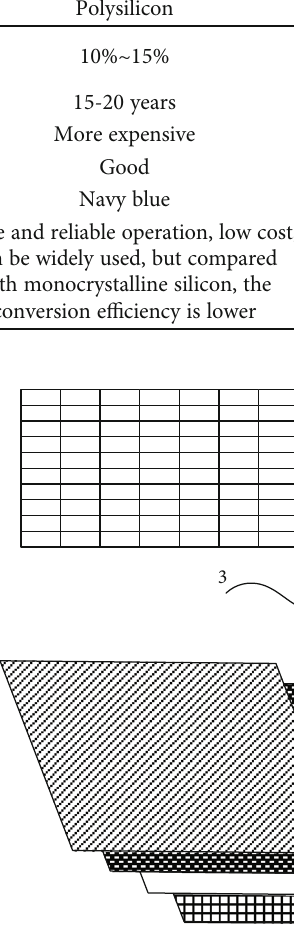
Figure 1: Schematic diagram of heat storage and heating system for photovoltaic power